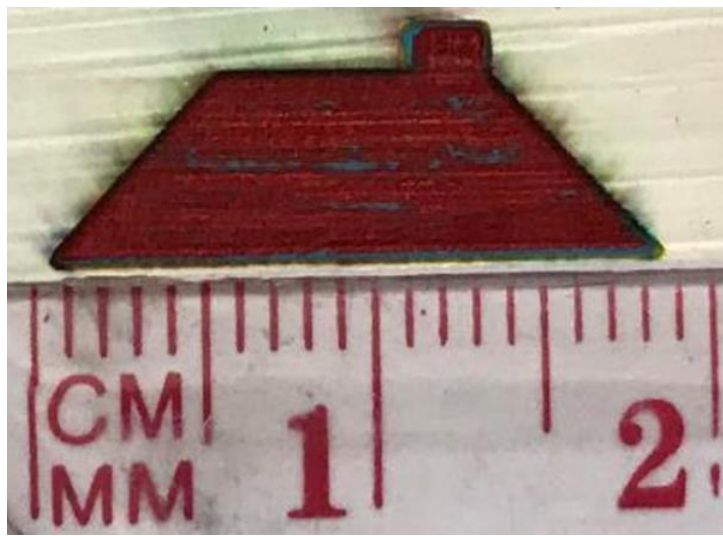
Figure 10. Roof part of the painting in red color.